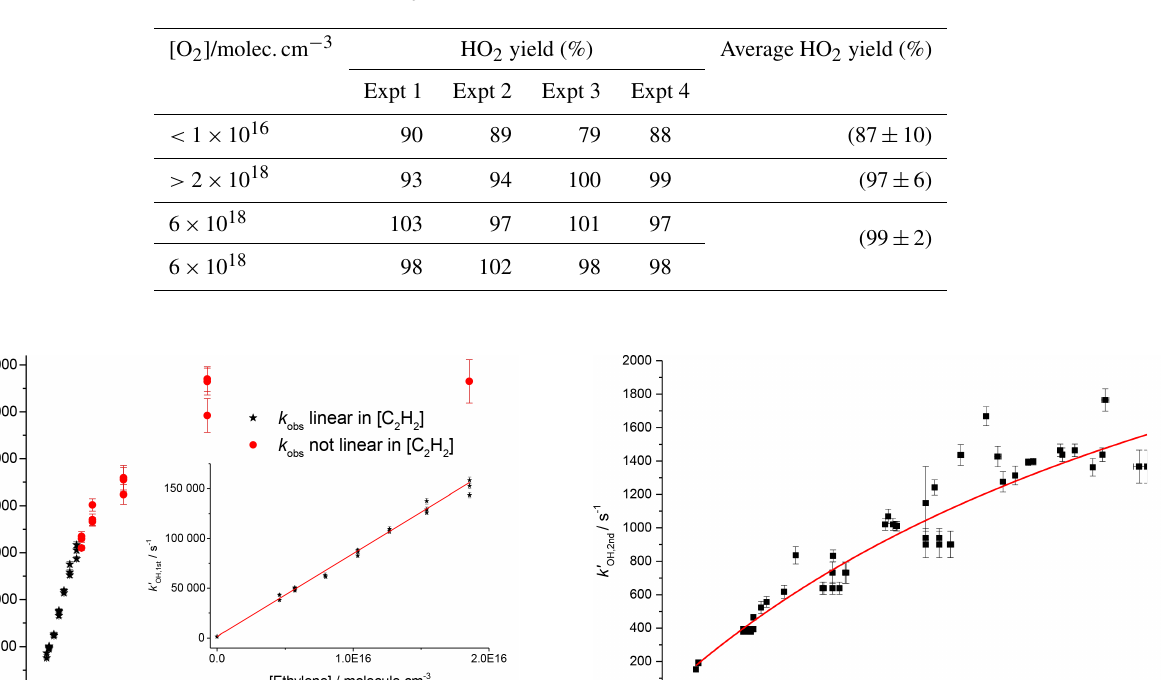
Table 1. HO 2 yields from the reaction of OH with CH 3 OH with varying [ O 2 ] carried out at 295K. Errors given as 2 σ .